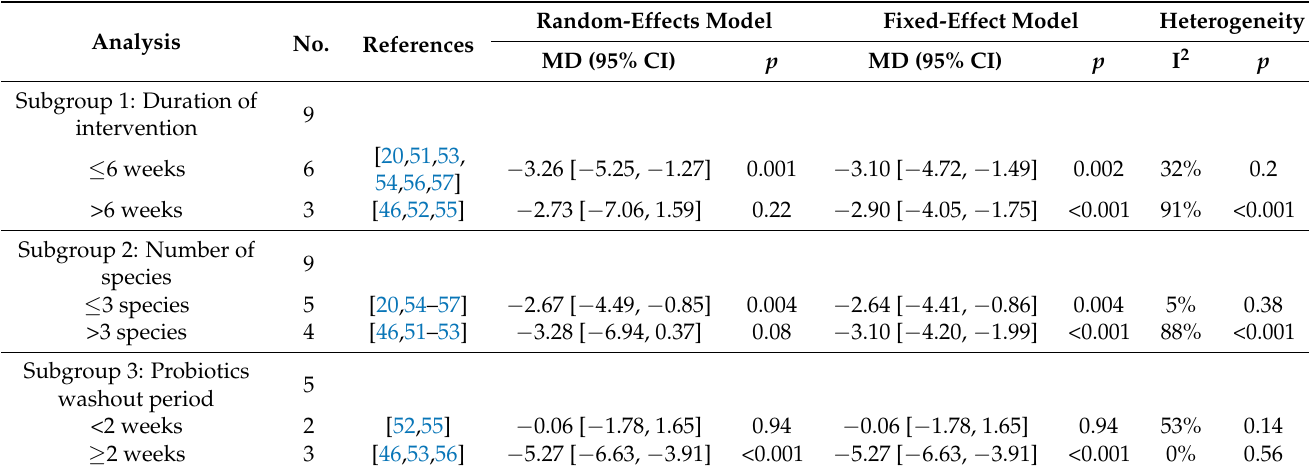
Table 2. Subgroup meta-analysis of the effect of probiotics on fasting plasma